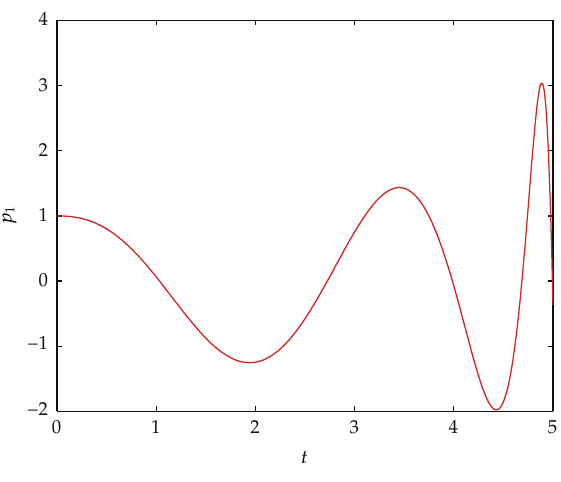
Figure 5: Generalized momentum p 1